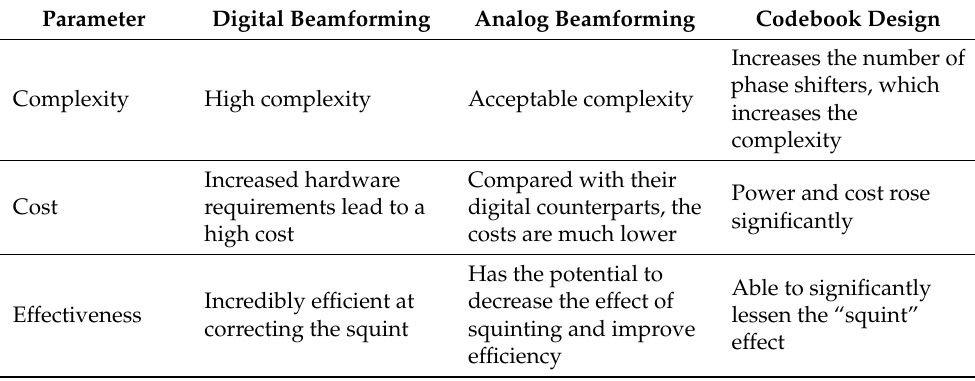
Table 1. Comparison among the main methods used to remove beam squint